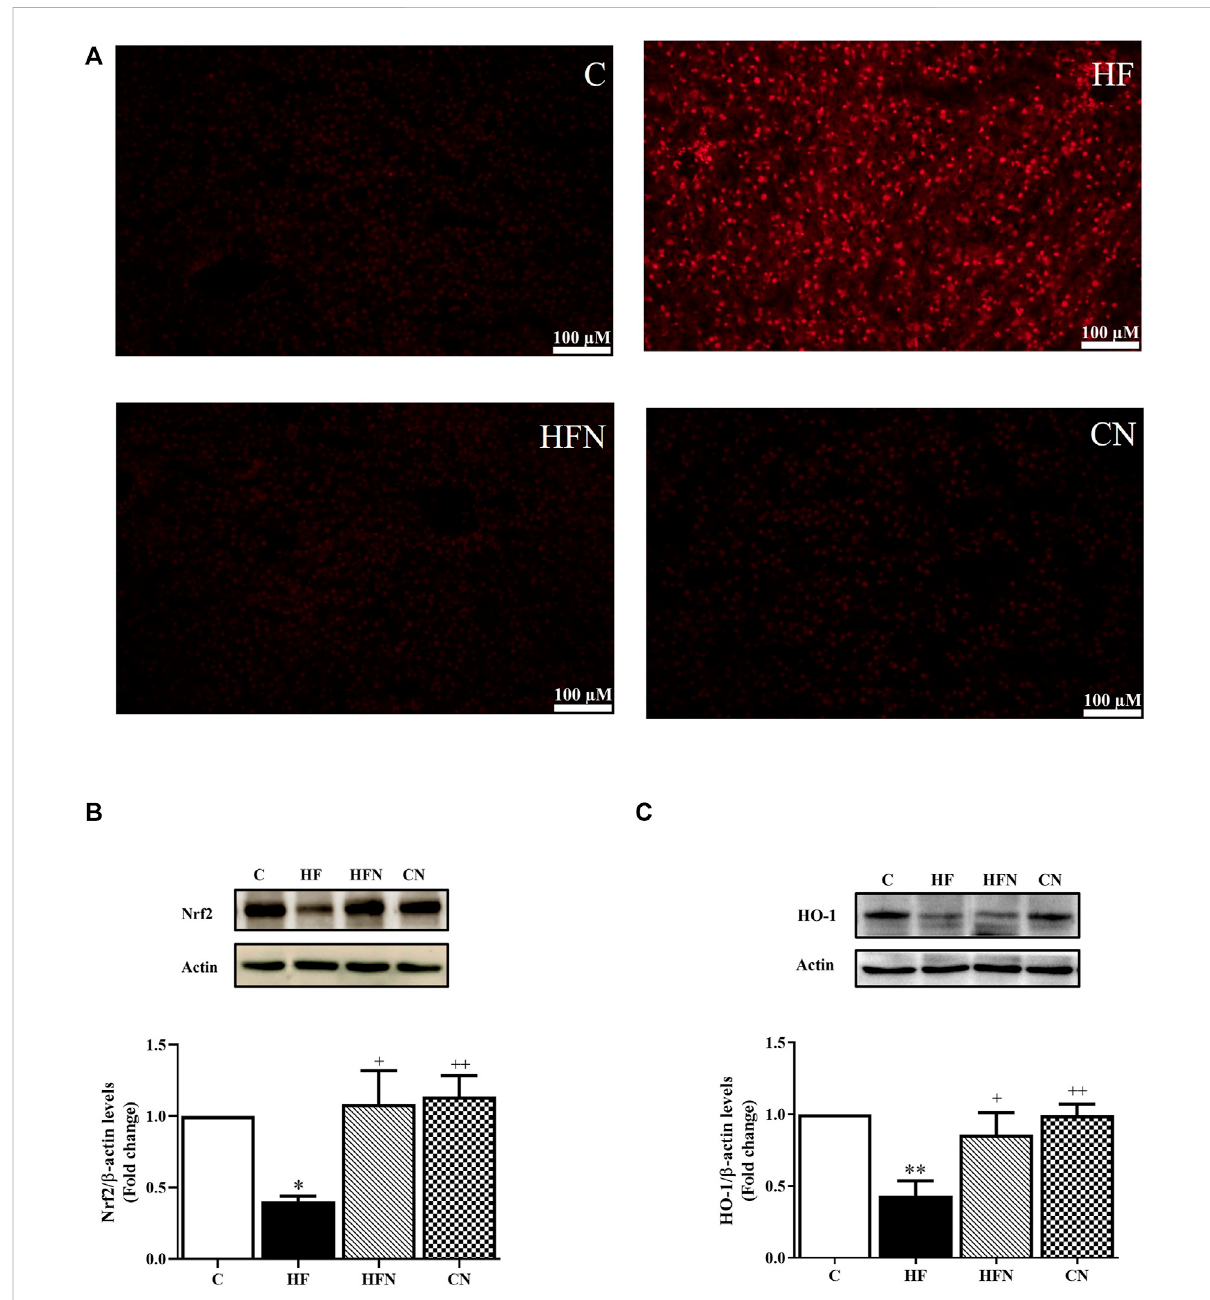
FIGURE 5 The effects of naringin on hepatic oxidative stress. (A) A representative the oxidative dye DHE staining images of liver section (magni fi cation ×20), hepatic protein expression of (B) nuclear factor (erythroid-derived 2)-like 2 (Nrf2) and (C) heme oxygenase-1 (HO-1) of control rats(C),fructose-fedrats(HF),fructose-fedratstreatedwithnaringinat100 mg/kgBW(HFN)andcontrolratstreatedwithnaringinat100 mg/kgBW (CN). Theresults areshown as themean±standarderror ofthemean(n= 5pergroup). * p < 0.05, ** p < 0.01 compared with thecontrol group; + p < 0.05, ++ p < 0.01 compared with the HF